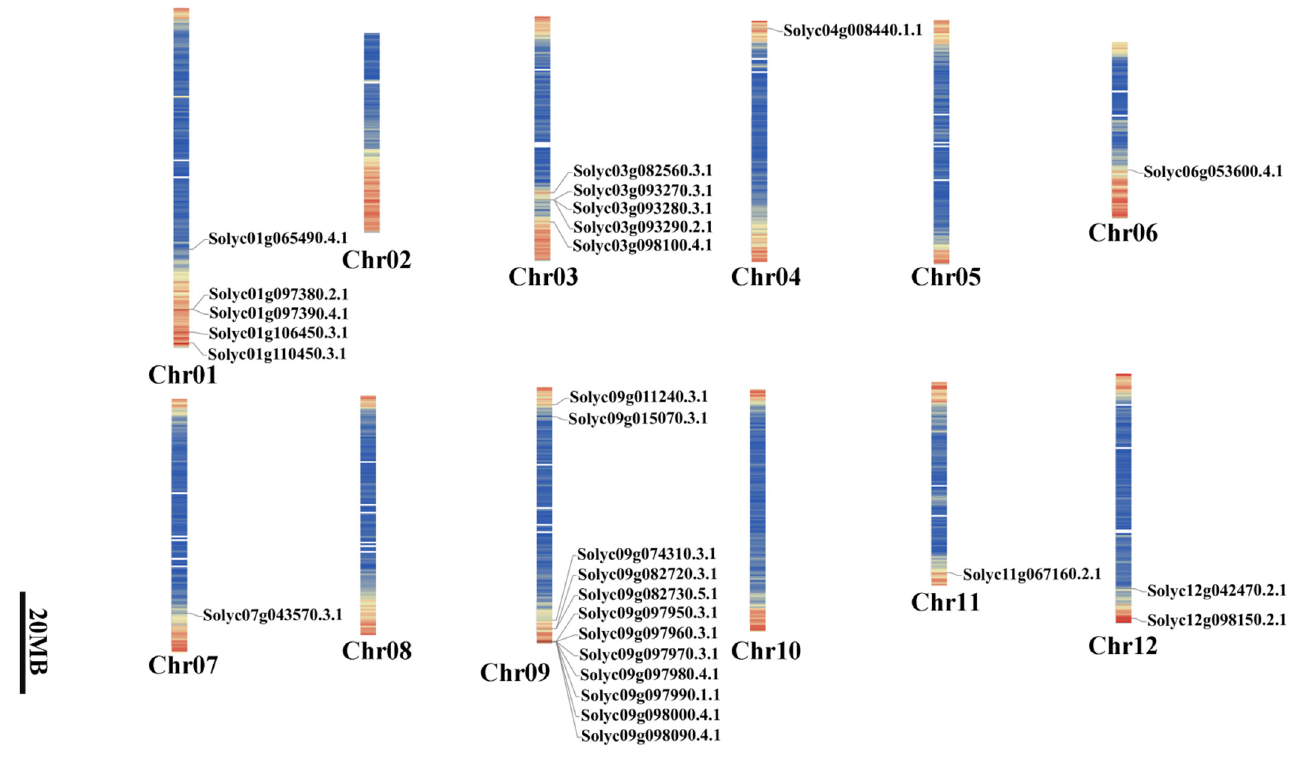
Figure 1. Genomic locations of the SlAKR gene on the genome of Solanum lycopersicum .